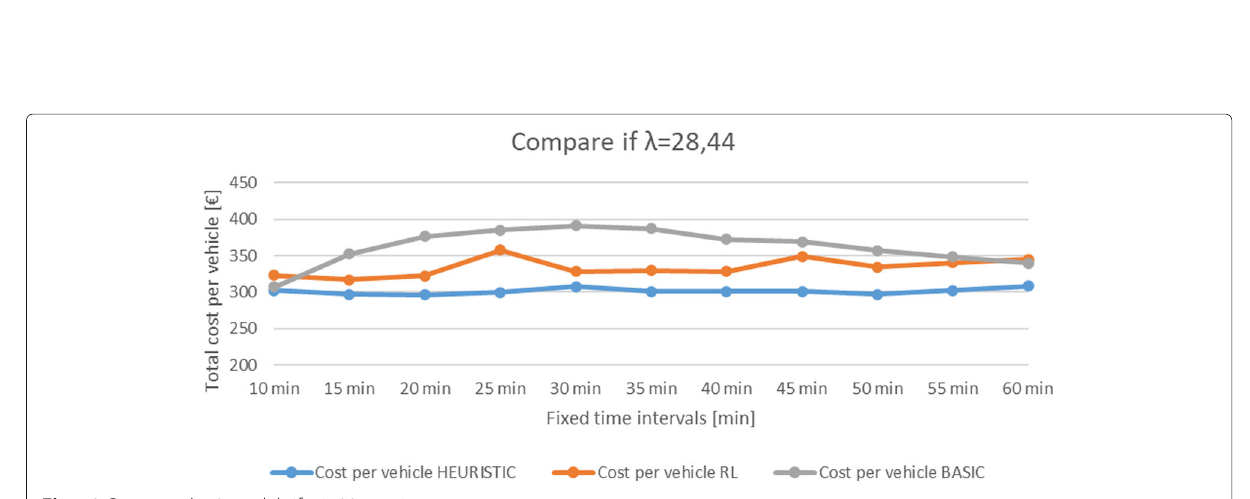
Fig. 10 Compare the 3 models if λ is 28,44 min